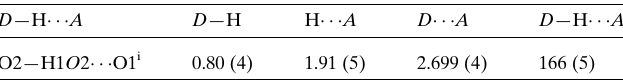
Table 1 Hydrogen-bond geometry (A˚ , (cid:2)